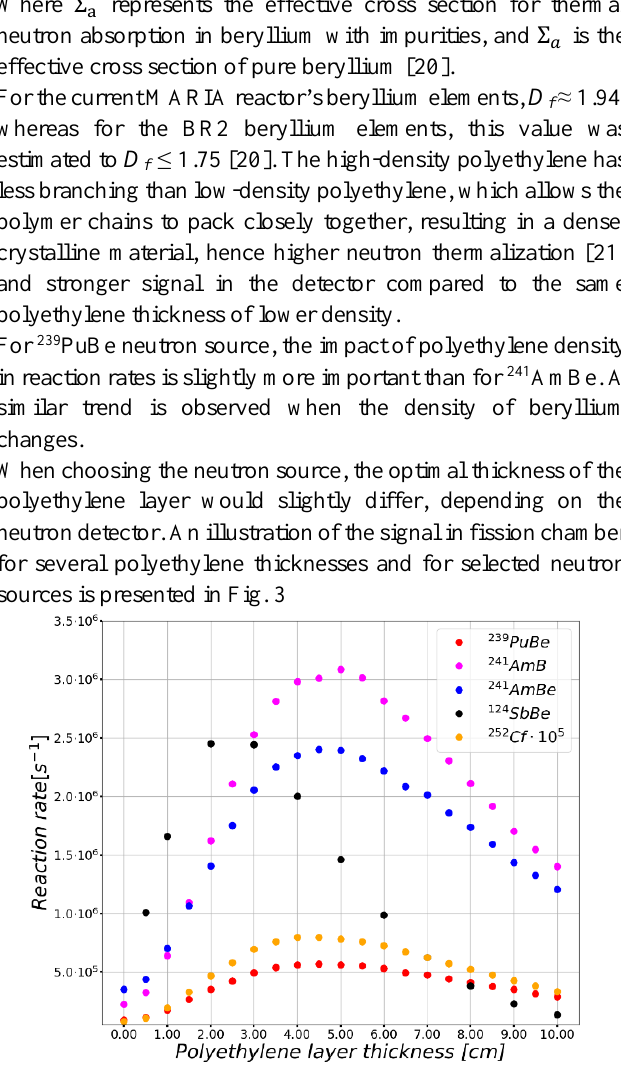
Fig. 3 – Fission reaction rates ( 235 U FC) induced by the neutron sources, depending on the polyethylene thickness (density 0.93 g/cm 3 ). (The maximum statistical uncertainty is 2σ = 3%), calculated in SERPENT2 [10].